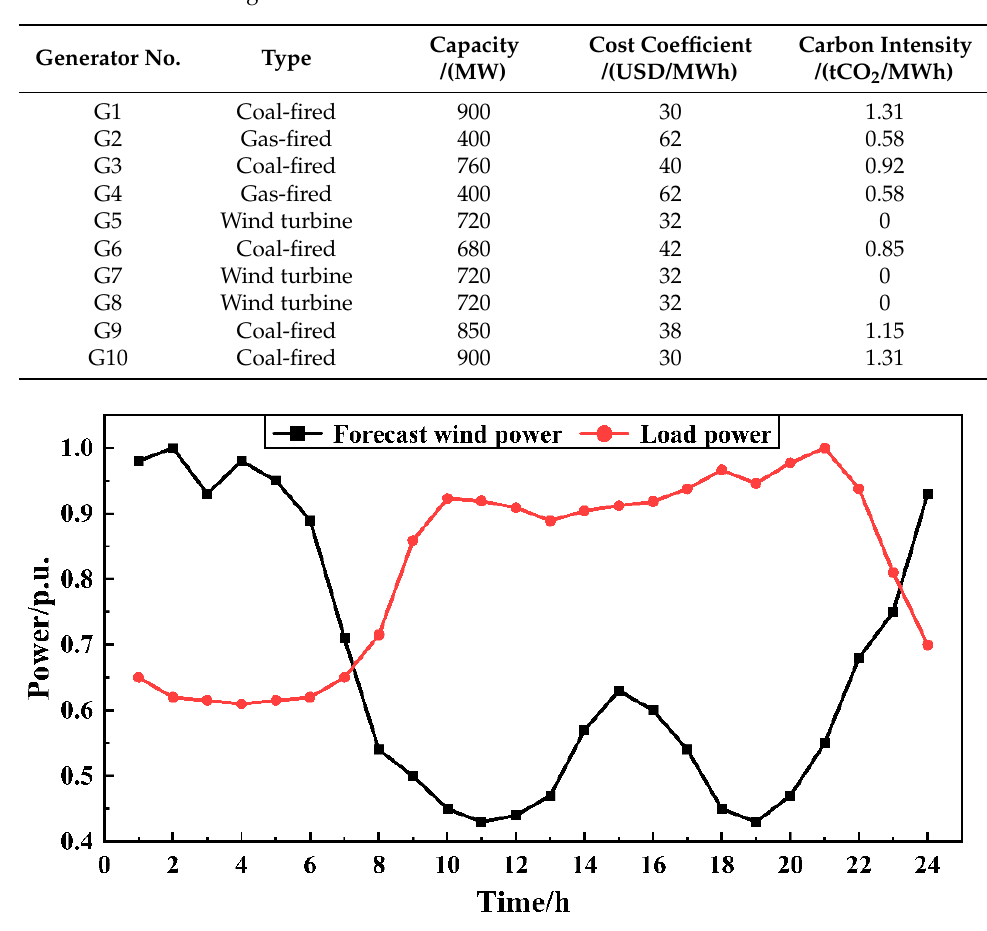
Table 1. Parameters of generators.